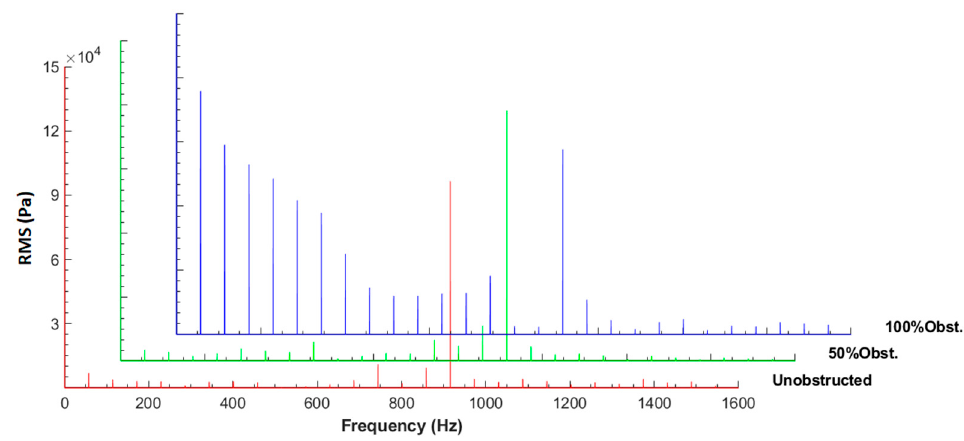
Figure 21. Frequency spectra in the rotating reference frame (monitor point R1) for different dis- tributor blockage sizes.